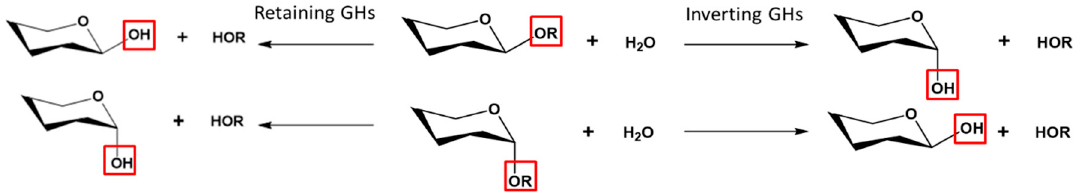
Figure 1. Mechanistic classification of GHs showing Inverting and Retaining GHs [20].